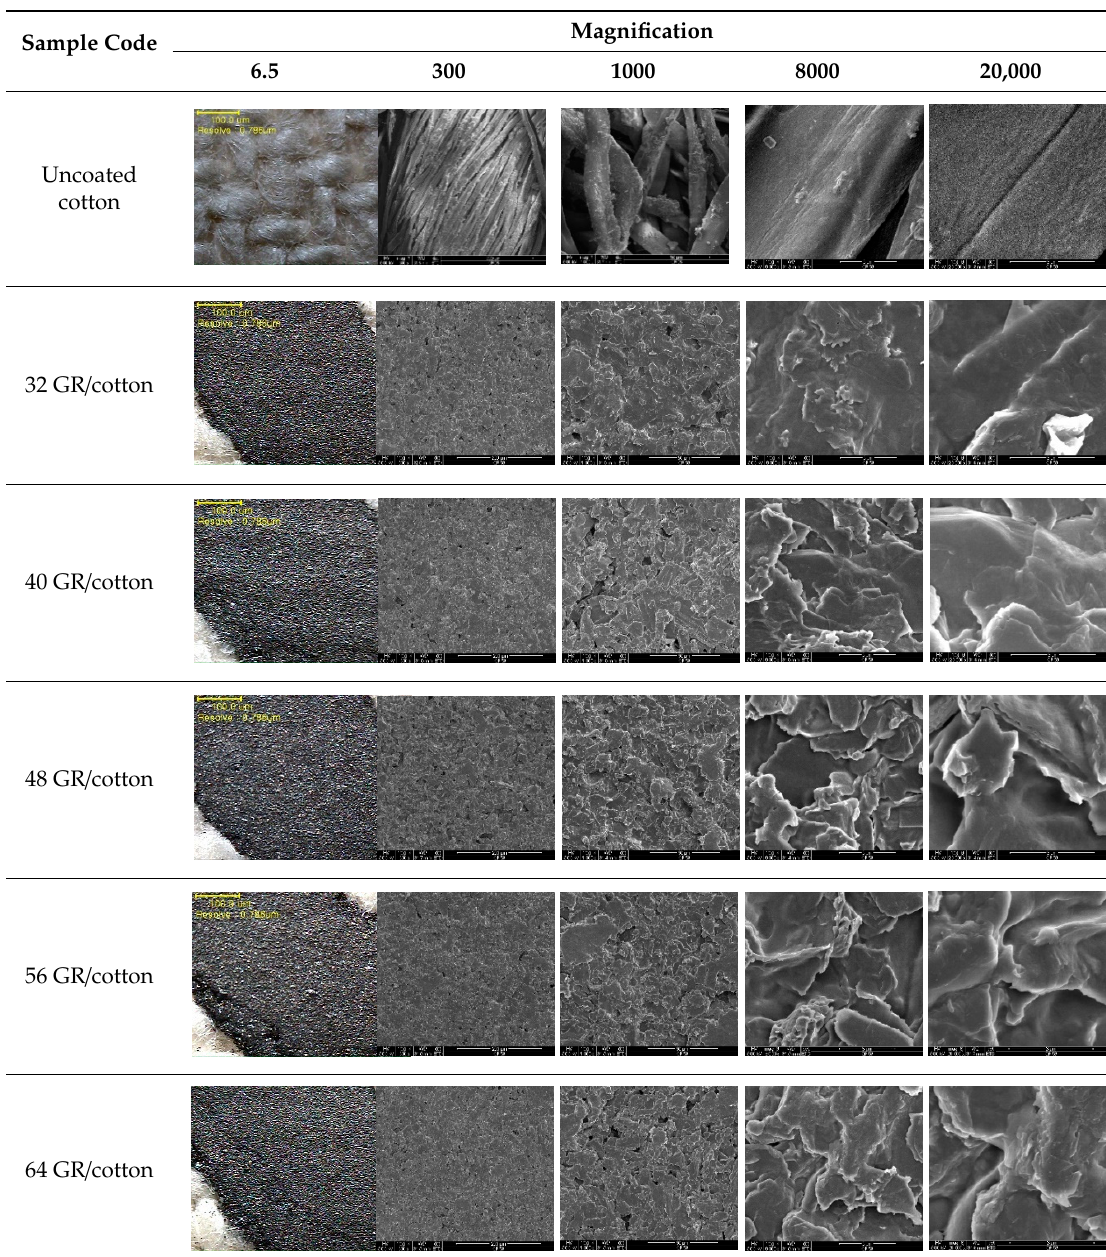
Table 2. Morphology of GR/cotton coated with various high-content of graphene nanoplatelets.